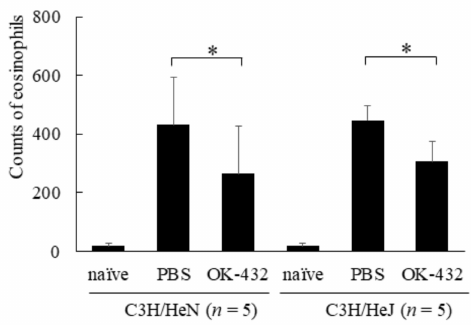
Figure 5. Sneezing rate in a murine model of C3H/HeN or C3H/HeJ mice systemically sensitized with OVA and receiving subsequent intranasal challenge of OVA. Naive mice underwent no systemic sensitization. PBS-treated mice were i.p. injected with PBS on day 0 and day 7. OK-432-treated mice were i.p. injected with 100 mg OK-432 on day 0 and day 7. Data were obtained and expressed as the mean of triplicate determinations ± SD. Per experimental group, five mice were used. *, p < 0.005.